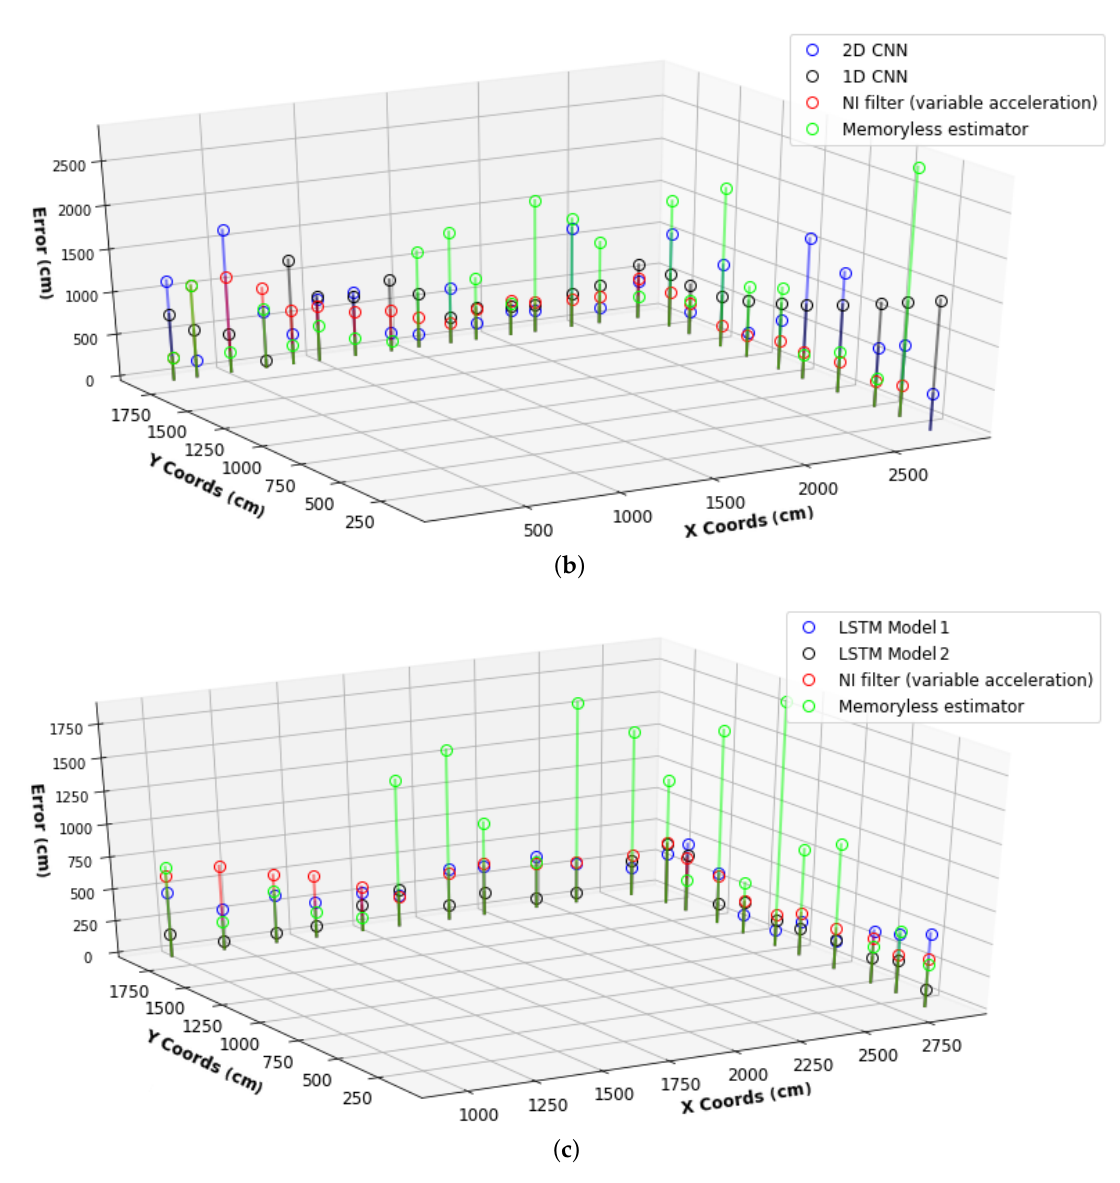
Figure 13. Individual tracking (dynamic positioning) error results on test points. Result comparison between probabilistic models and ( a ) MLP deep architectures ( b ) 1D CNN and 2D CNN ( c ) LSTM Model 1 and LSTM Model